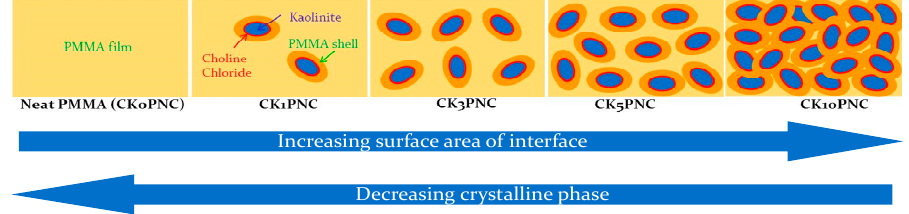
Figure 3. Schematic illustrations of neat PMMA film and the composite films to show the impact on interface and crystallinity of modified kaolinite.